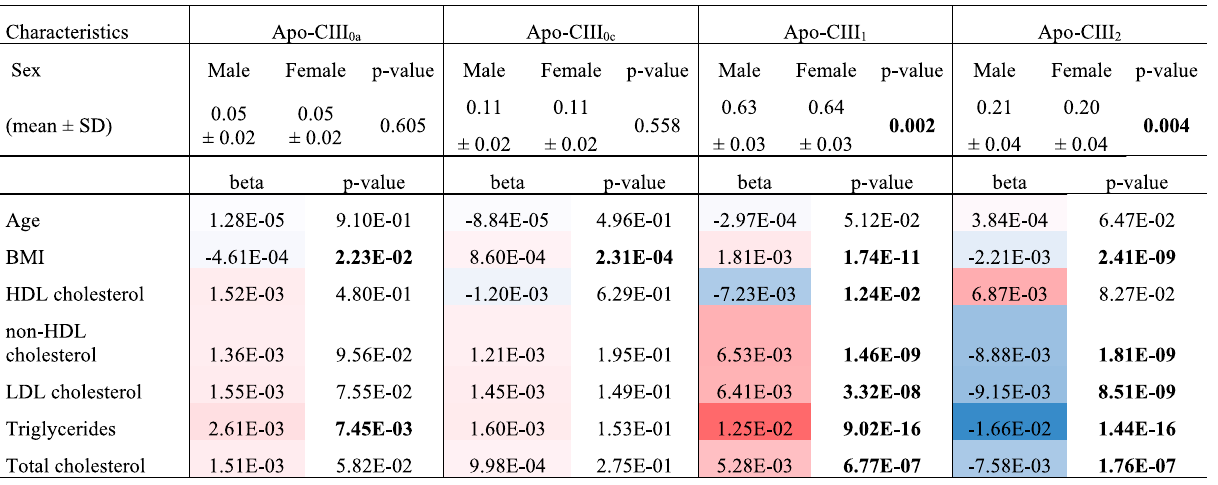
TABLE 3 | Associations of apo-CIII glycosylation with clinical